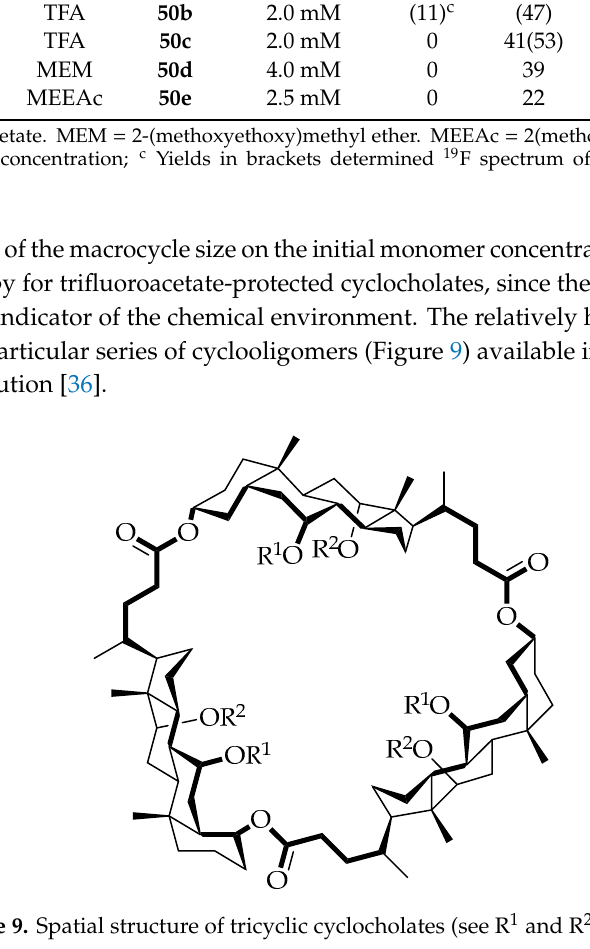
Figure 9. Spatial structure of tricyclic cyclocholates (see R 1 and R 2 at Table 1).